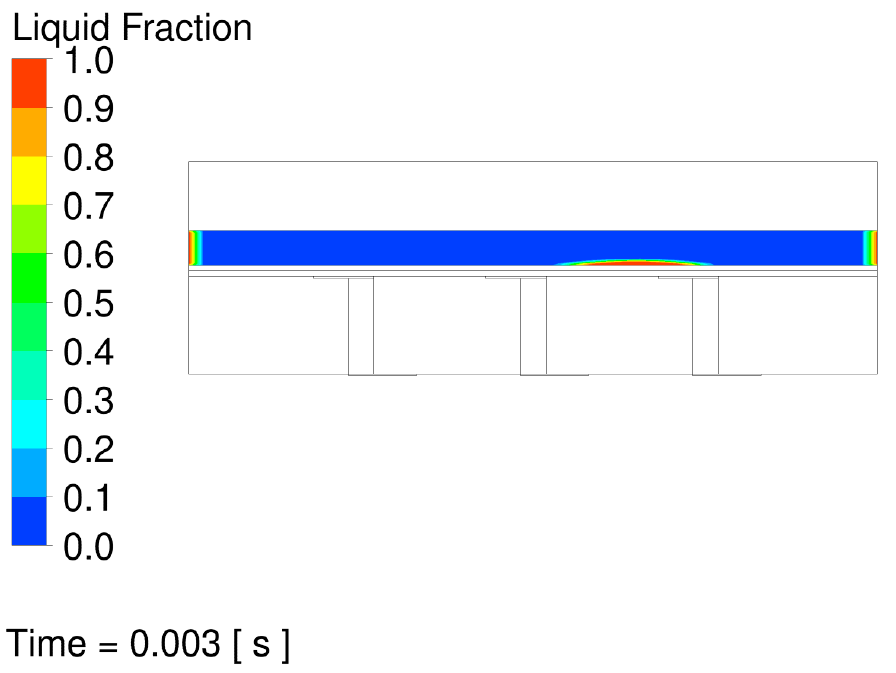
Figure 10. Contours of liquid fraction after 3